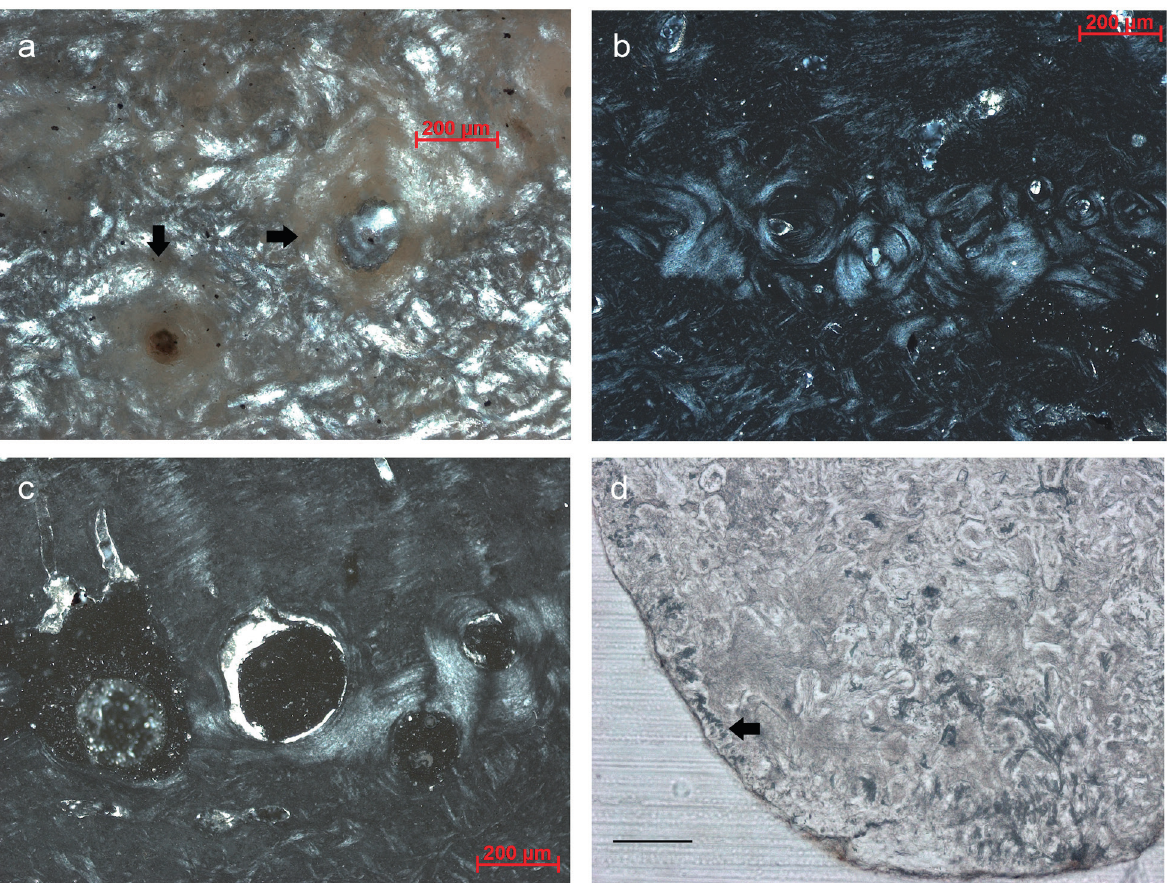
Figure 4 - Details of the vascularization of Riostegotherium yanei : a) the central portion of the specimen LMh 05 showing the sole primary osteon of the deep cortex (vertical arrow) and one of the secondary osteons of the core at the mid region of the tongue (horizontal arrow) (UFrJ-DG 1051M); b) and c) the secondary osteons and resorption areas of the core of the specimen LMh 06 at the tongue (UFrJ-DG 1050M and UFrJ-DG 1049M respectively); d) transversal section of the posterolateral portion of the specimen LMH 05 (UFRJ-DG 1051M) showing Sharpey fibers at the osteoderm margin. Scale bar = 50